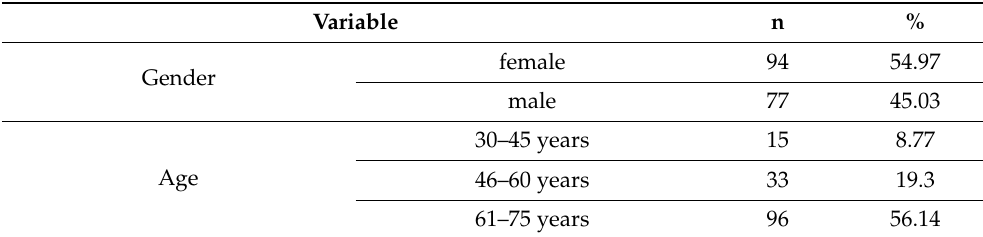
Table 2. Characteristics of the study